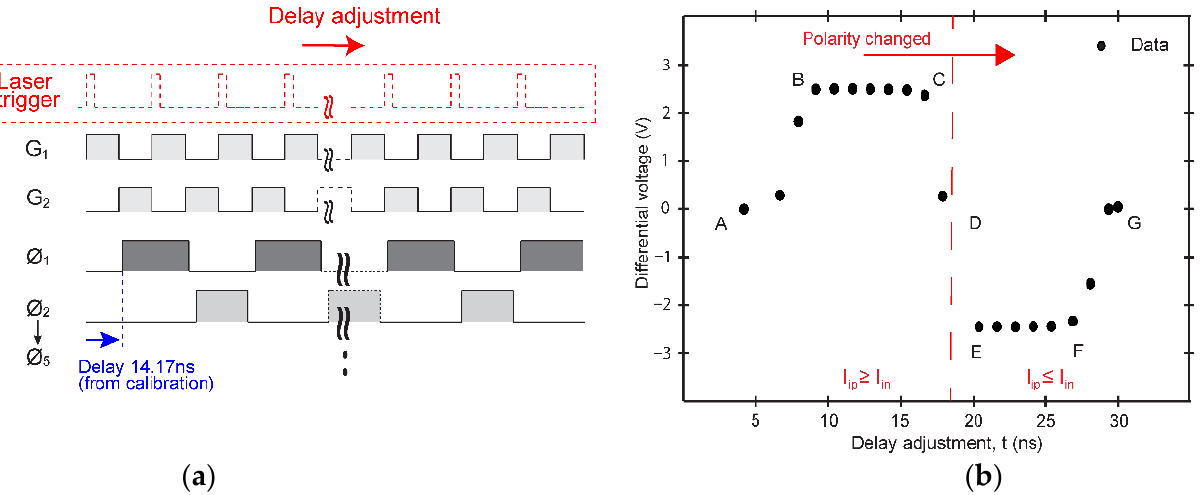
Figure 13. ( a ) Timing configuration for the SRS chip evaluation with a laser source. ( b ) The measurement result obtained for the SRS chip across laser delay adjustment.